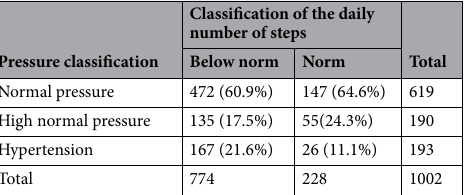
Table 3. Classification of the daily number of steps and blood pressure in children. “norm”—at least 11,500 steps a day; “below norm”—a number of steps a day below 11,500.